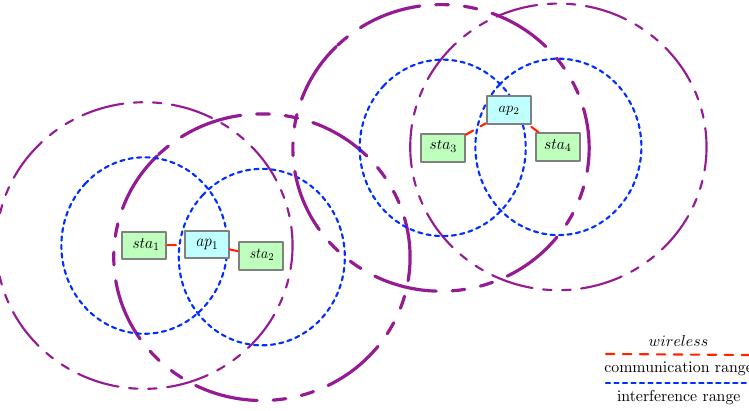
Figure 5. Communication and interference ranges for stations in a simple